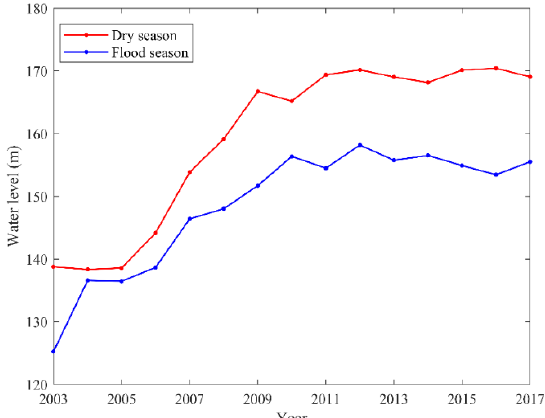
Figure 4. Variation of monthly average water level in dry and flood seasons from 2003 to 2017 in the TGRA.